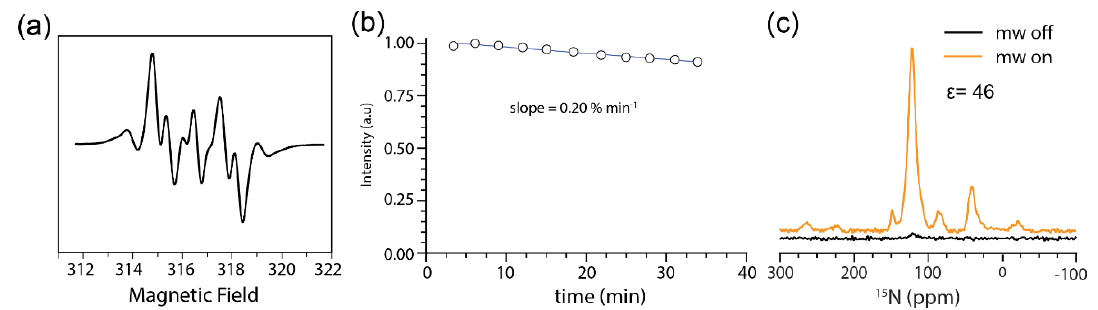
Figure 2. EPR analysis of AMPUPol stability in non-stimulated JLat T cells. ( a ) EPR spectra of AMUPol in JLat T cells at 9.4 GHz. ( b ) Integrated area of EPR signal over time. JLat cells were prepared with 10 mM AMUPol in 10% DMSO/90% phosphate buffered saline (PBS) and analyzed at room temperature. Data shown is one of two independent experiments. The average decay is 0.20% min −1 ± 0.08 s.d. ( c ) Comparison of microwave-on and -off spectra of selectively 15 N- labeled JLat cells measured at 90 K. Spectra were acquired at 7.05 T with 197.674 GHz microwave irradiation, 4.5 kHz magic angle spinning (MAS) and 2048 transients.